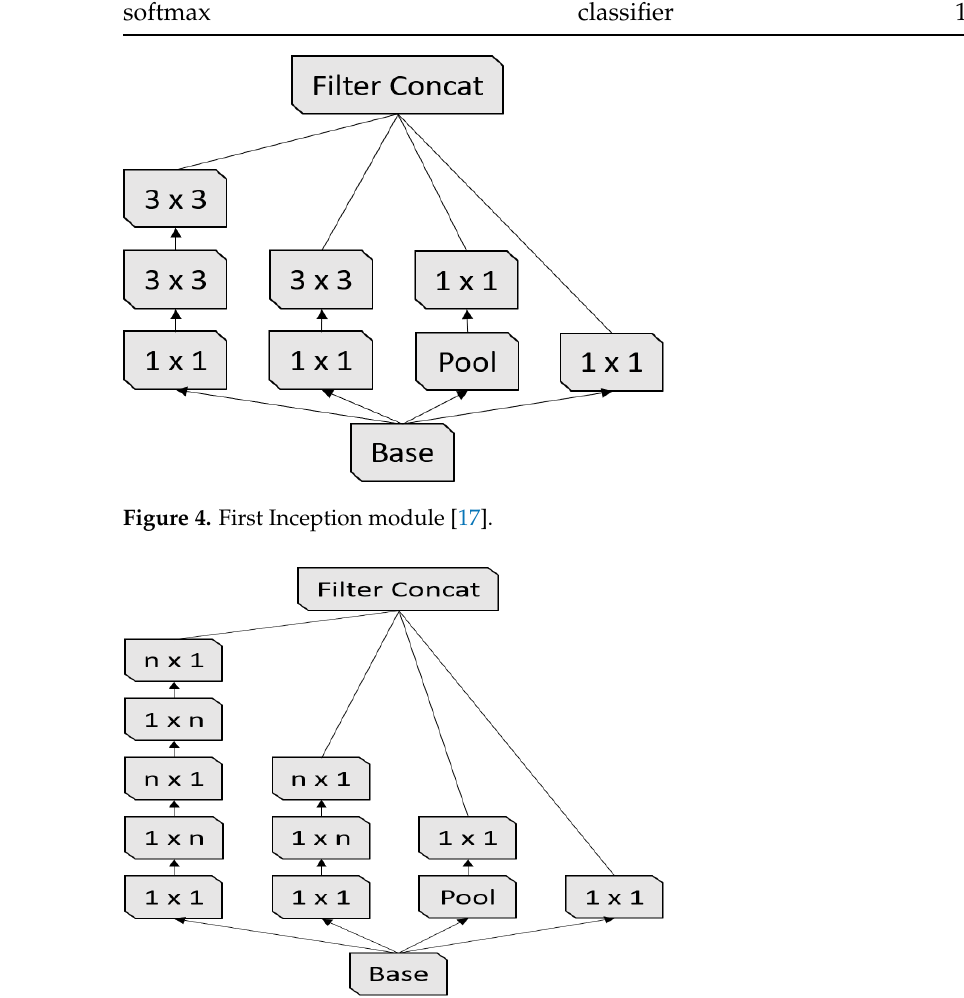
Figure 5. Second Inception module